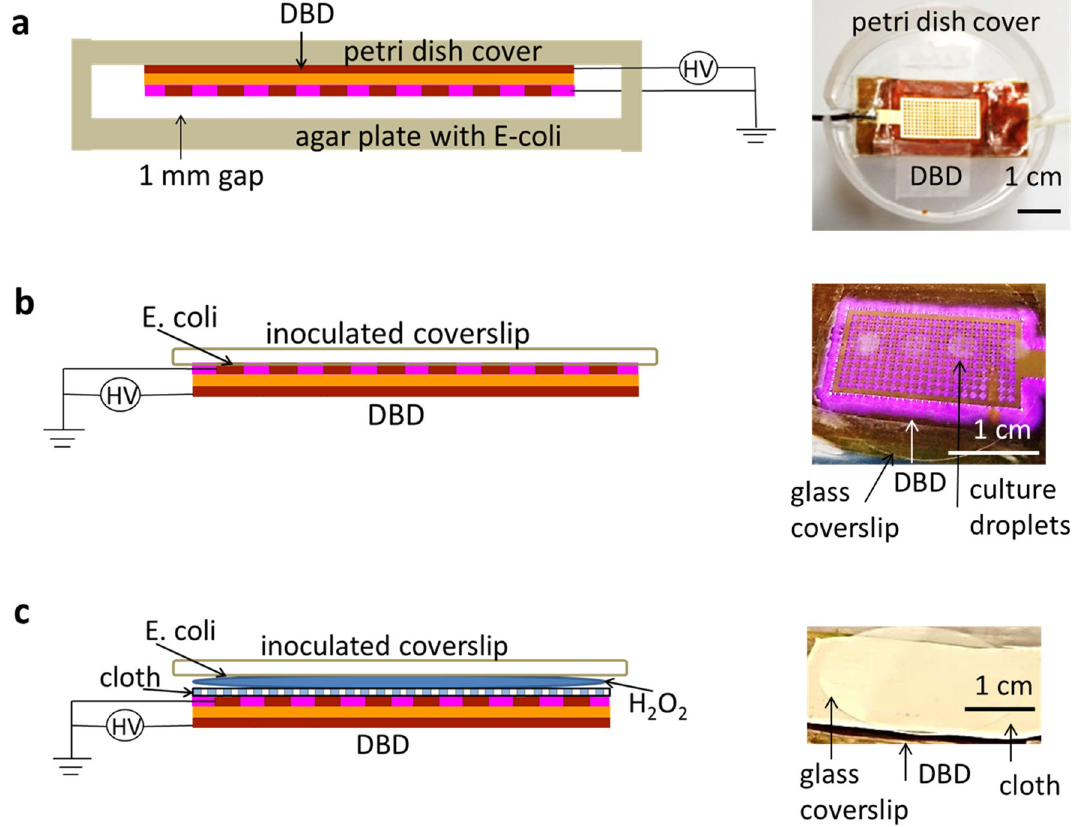
Figure 2. Flex-DBD at a short distance, in contact with a surface, or with a liquid disinfectant. ( a ) The flex- DBD is fixed to the inside of a petri dish lid. ( b ) Inoculated coverslip is directly in contact with the flex-DBD. ( c ) The flex-DBD is covered by a semi-permeable cloth with a liquid disinfectant on top; the inoculated cover slip is placed so that the bacterial culture is in contact with the disinfectant (20 µl dried culture, 10 µl 3% H 2 O 2 on metal (aluminum), and on glass (microscope cover slips). For treatment of bacterial plates, we spread 50 µl of a fresh bacteria culture on LB-agar plates and treated the plate surface with the flex-DBD attached to a lid, placed over the petri dish (Fig. 2a), for different amounts of time. We then incubated the plates overnight at 37 °C and visually compared them to untreated control and examined for areas that were clear of bacteria. To test the disinfection of the textile-type surfaces, 100 µl of E. coli OP-50 was spread on textile-like polyethylene material (Tyvek, DuPont). The petri dish cover with the flex-DBD attached was placed over the inoculated area. The petri dish cover used in this experiment was cut to maintain a 1–2 mm distance between the treated surface and the face of the flex-DBD. Each region was treated for a set amount of time and at the end of the treatment time, immediately stamped with an LB contact plate (Carolina Biological Supply Company). The untreated area was stamped as the control. The contact plates were incubated for 24 h at 37 °C. Qualitative results were assessed visually by observing GFP expression using a gel imaging station (FastGene Blue/Green LED GelPic Box, Nippon Genetics). To quantify disinfection, bacteria ( E. coli 10-beta, Standard E. coli AMS 198 or OP50-GFP) were inoculated on glass coverslips (25 mm diameter). Four droplets of 5 µl each (20 µl) of the bacterial culture (starting concentra- tion 10 8 CFU/ml) were placed onto each coverslip and allowed to dry for approximately 40 min. The slides with dry bacterial culture were then placed onto the flex-DBD with the inoculated side directly in contact with the discharge (Fig. 2b). The coverslips were treated for 10, 30, 90, and 270 s. At the end of the treatment time, the treated coverslip was placed in a centrifuge tube with 7.5 ml LB, enough to cover the coverslip. The tubes were vortexed on a medium setting for 20 s to recover the bacteria from the treated surface but not damage the cell membrane. The resulting bacterial suspension was spread on LB-agar plates and incubated for 24 h. Cultures were then counted and the number used to calculate the logarithmic reductions of bacterial concentration. All disinfection experiments were conducted with the flex-DBD operating at 3 kV, 20% duty cycle, and 40–50 °C. We tested the efficiency of the flex-DBD disinfection in conjunction with a commonly available 3% solution of H 2 O 2 . The discharge in the flex-DBD is suppressed by water so we used a semipermeable polyethylene mate- rial (Tyvek, DuPont) to keep the H 2 O 2 solution from the surface of the flex-DBD (Fig. 2c). Pieces of material were disinfected by soaking for 5 min in a 70% solution of isopropyl alcohol then dried thoroughly for at least 30 min. For each trial, we placed a piece of the sterile material on top of the operating flex-DBD and five 2 µl droplets of 3% H 2 O 2 solution on top of the polyethylene material. We then placed an inoculated glass coverslip on top of the solution with the bacteria in contact with the solution (Fig. 2c). At the end of each treatment, we